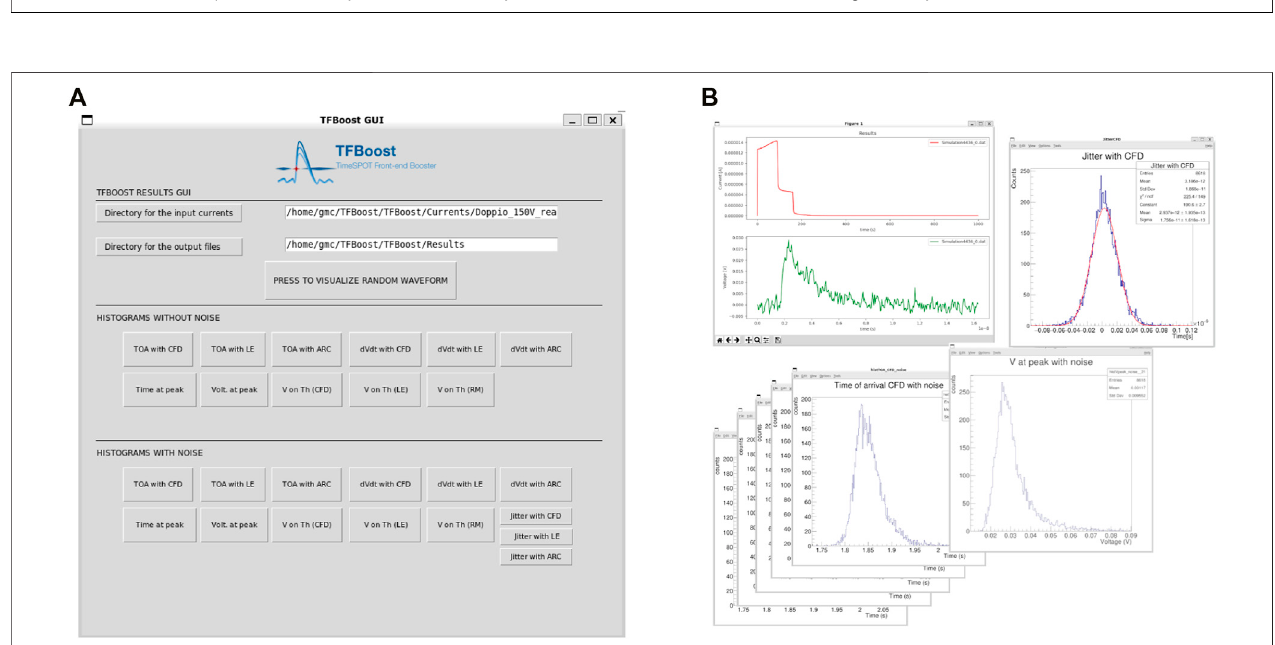
FIGURE 8 | TFBoost GUI results window (A) , from which it is possible to retrieve and plot the waveforms and the ROOT histograms (B) .